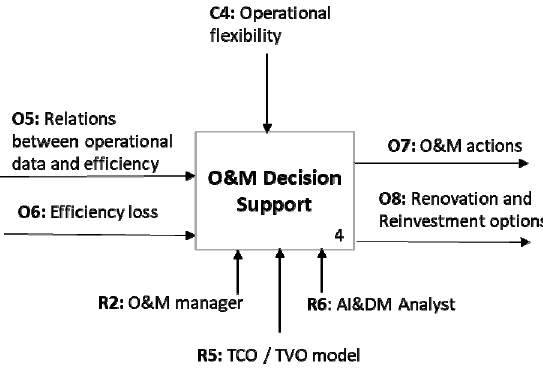
Figure 9. Level-1 representation of the O&M Decision support process.